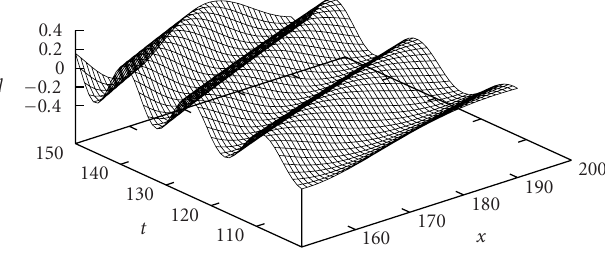
Figure 5.10. Wave motion due to initial displacement when t = 100 to 150, x = 150 to 200; (cid:1) = 0, D = 0.